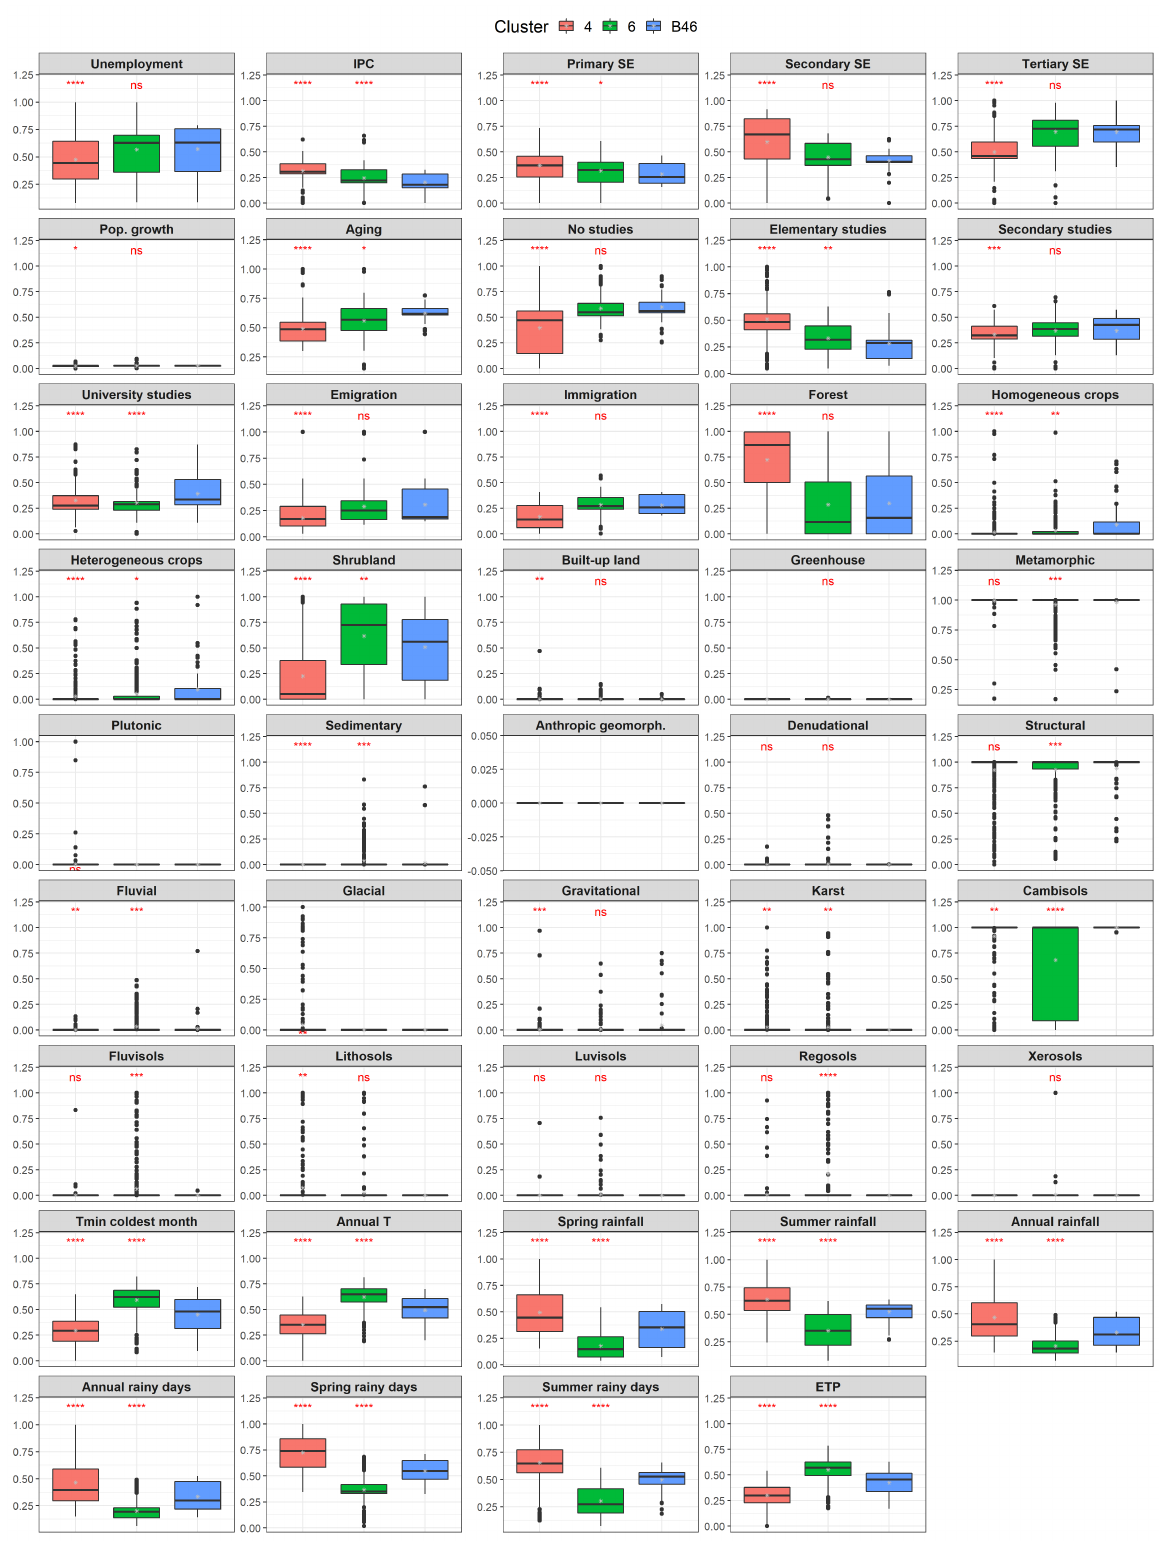
Figure A5. Comparison of the socio-ecological variables between Sectors 4 and 6 and the boundary between them (B46). Statistical significance is shown as: ns: p -value > 0.05; *: p -value ≤ 0.05; **: p -value ≤ 0.01; ***: p -value ≤ 0.001; ****: p -value ≤